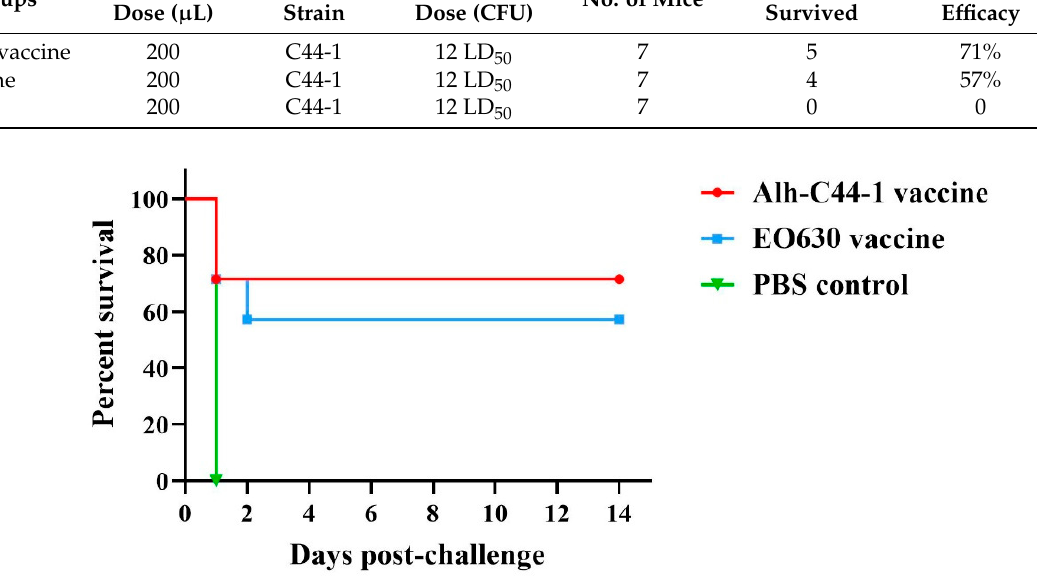
Figure 2. Survival rates of a mouse model immunized with traditional vaccines, after challenge with the serogroup B strain. All mice were challenged with a culture of virulent P. multocida C44-1 strain (12 LD 50 /mouse) by the intraperitoneal route. The mice were observed for 14 days post-challenge.